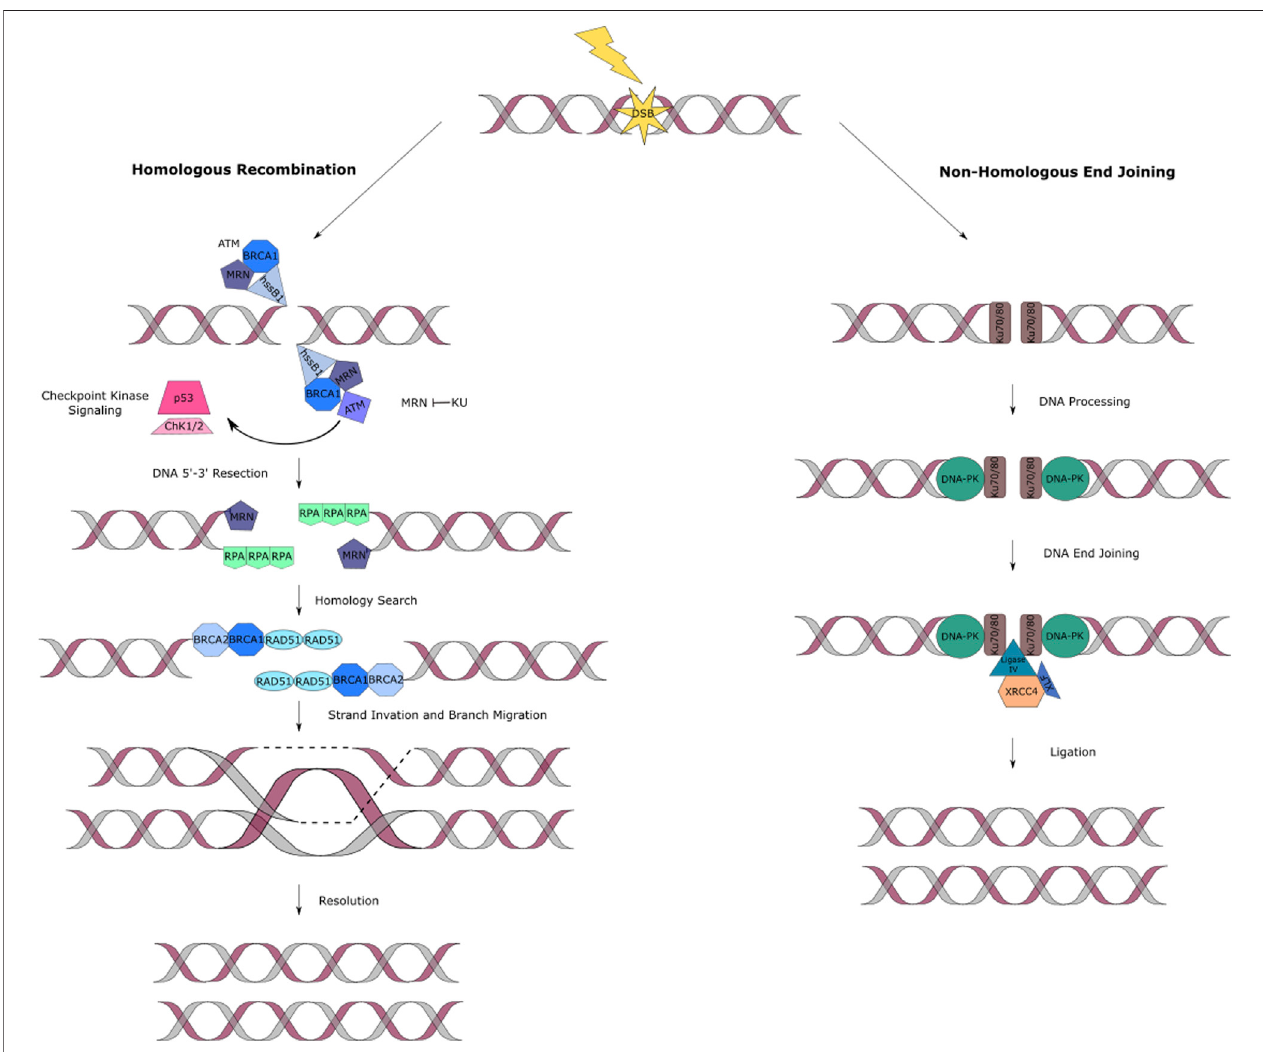
FIGURE2| DNA doublestrand break repair pathways. (A) HR fi xestwo-ended DSBsby aresection process. Arecombinase willthen induce strand invasion. The singlestrand isthen extended, using thecomplementarystrand astemplate.Recapture ofthe secondend occursfollowedbyligation. Themain proteins involvedinthis pathway are hSSB1, MRN complex, RPA, BRACA1/2 and Rad51. (B) NHEJ of DSBs in DNA is accomplished by a series of proteins that work together to carry out the synapsis, preparation, and ligation ofthe broken DNA ends.The main proteinsinvolved in NHEJ eukaryotes are Kuand DNA-PK complexes,XLF and the XRCC4/ DNA ligase IV